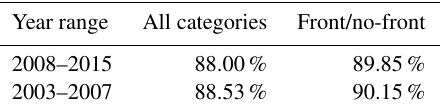
Table 2. Categorical accuracy values over the training and valida- tion time ranges for the case where all categories are considered independent and the simplified front/no-front